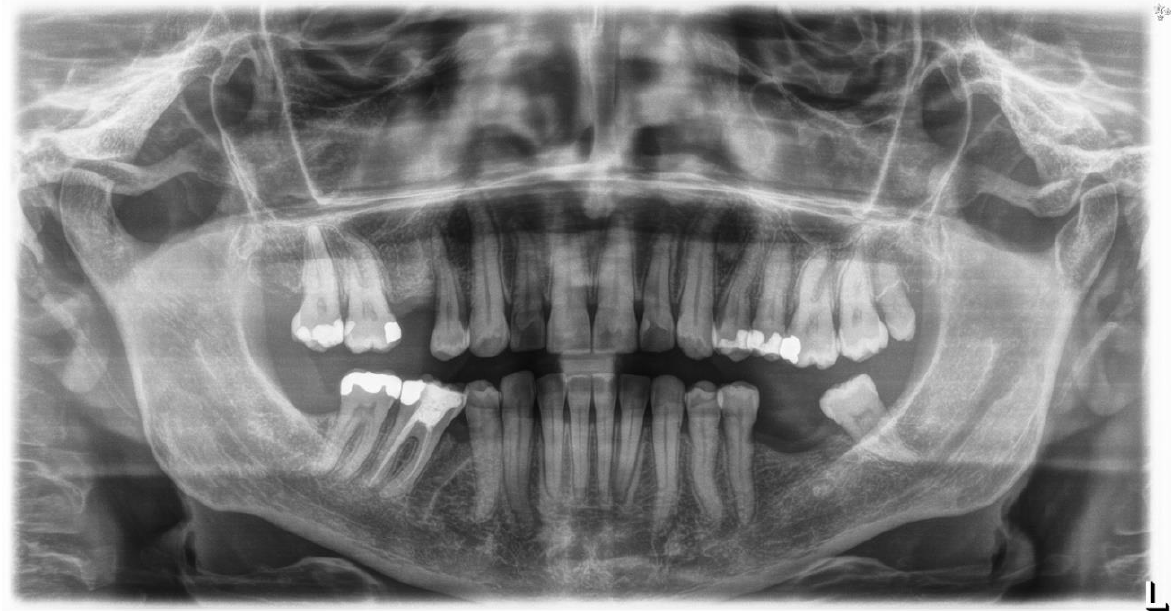
Figure 9. Pre-treatment orthopantomography.